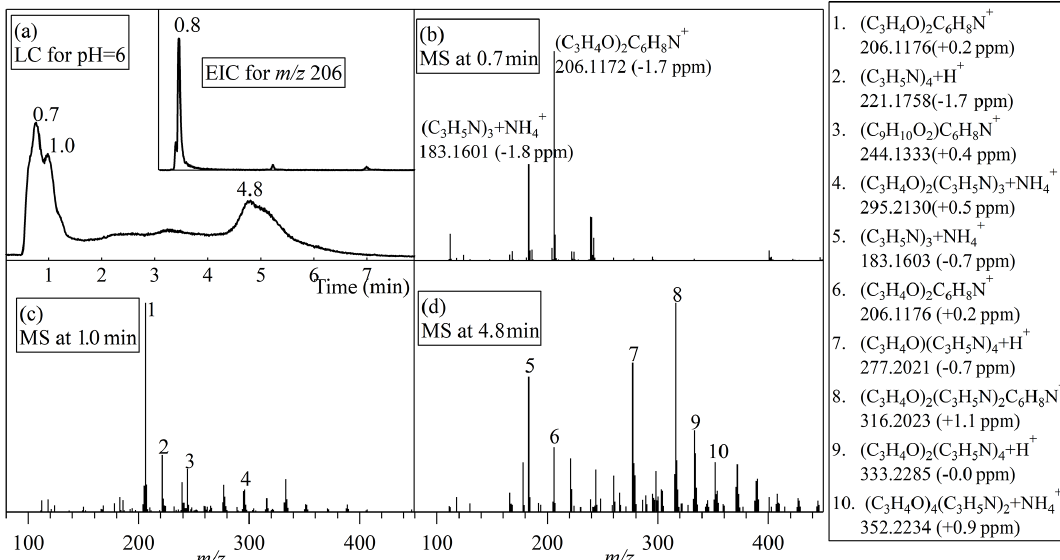
Figure 6. The UPLC HRMS results for the acrolein reaction with ammonium in the mildly acidic bulk solution. (a) A liquid chromatographic (LC) trace for a bulk solution sample with pH = 6. The insert is the extracted ion chromatogram (EIC) for m/z 206. (b–d) The mass spectra for the peaks around 0.7, 1.2 and 4.8min. The m/z values and the corresponding assigned formulae for the main ions are marked. The figures in the parentheses are the fractional deviations between the detected and theoretical m/z of the assigned ionic